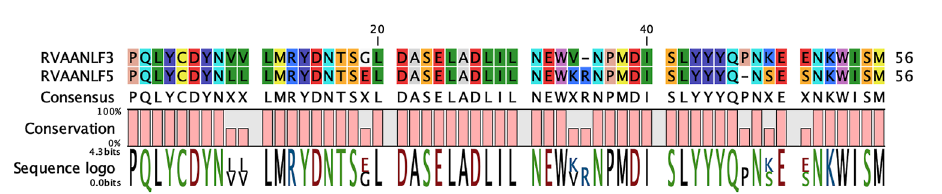
Figure 2. Amino acid sequence alignment of 2B64I-ANLF3/2018 (designated RVAANLF3) and 2B64I- ANLF5/2018 (designated